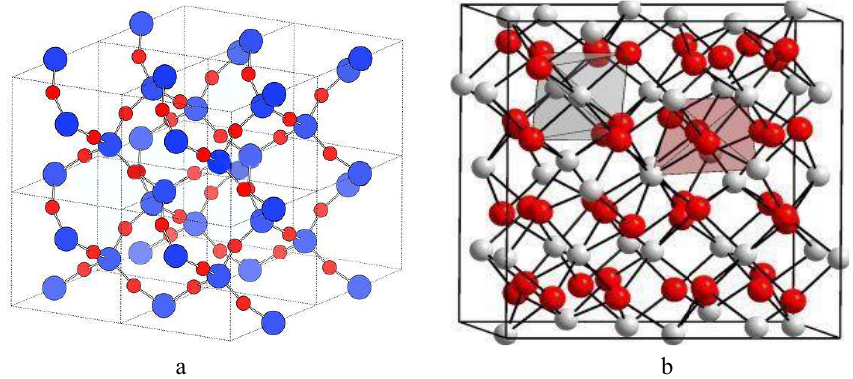
Figure 15. Molecular structure: ( a ) SiO 2 cell; ( b ) Al 2 O 3 cell [37].